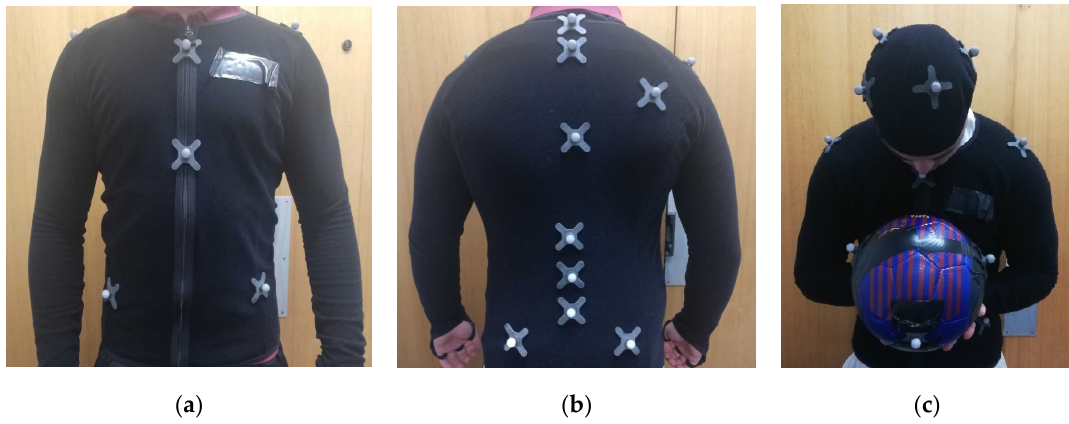
Figure 1. ( a ) anterior view of Rizzoli Trunk Protocol retroreflective marker set; ( b ) posterior view of Rizzoli Trunk Protocol retroreflective marker set; and, ( c ) hat and ball retroreflective markers. During the experiment, a full body motion capture suit was worn to ensure only the markers were reflective.